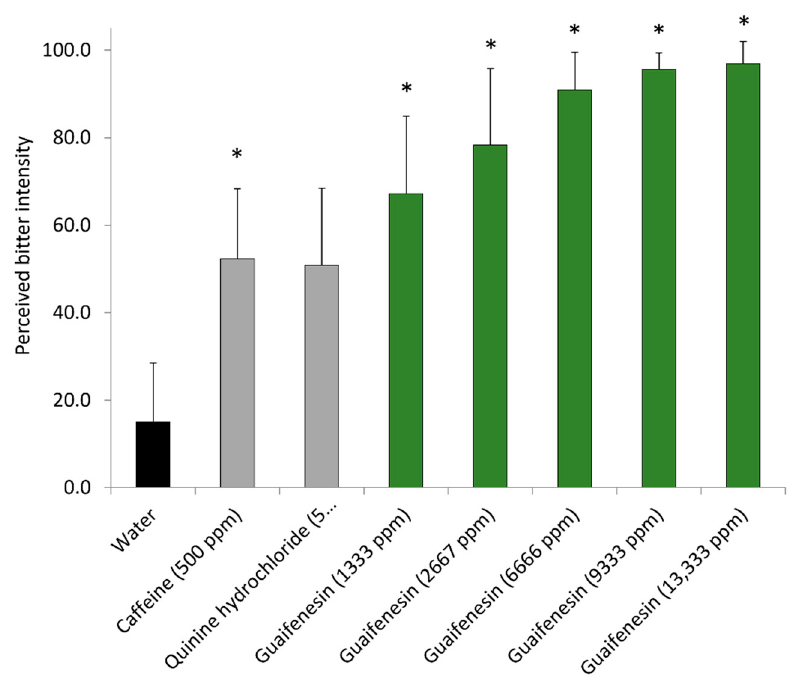
Figure 9. Bitter intensity of Guaifenesin. A panel of 15 trained volunteers were asked to taste (sip and spit) and rank the perceived bitterness (structured but continuous scale of 0 [no bitter taste]–100 [very strong taste]) of aqueous solutions containing typical concentrations of standard bitter compounds caffeine and quinine HCl and different concentrations of guaifenesin (1333 ppm–13,333 ppm, 6.7– 67.3 mM) against water as control. Data presented as mean +/ − standard deviation. Statistics: ANOVA on ranks with post-hoc Dunn’s method compared to control (water); * indicates significance with p ≤ 0.05.